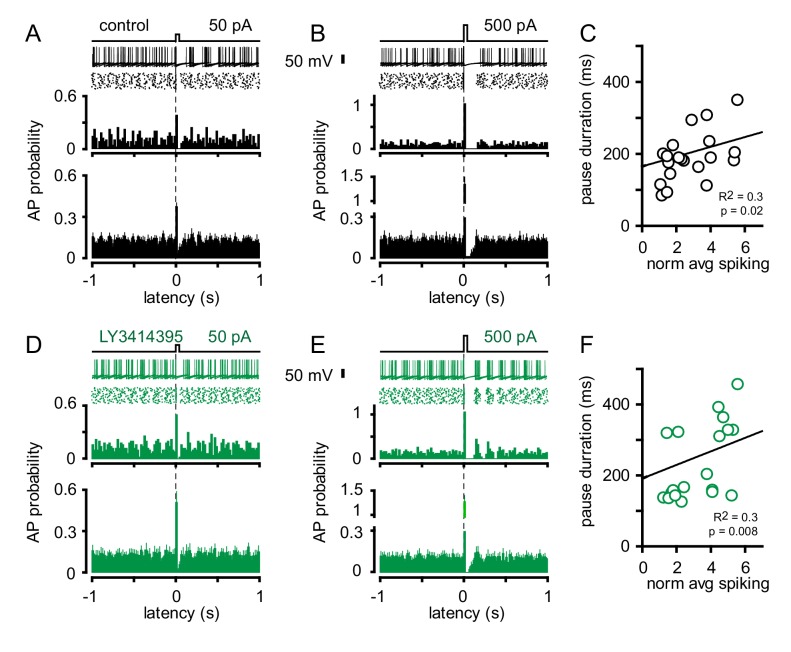
Current injections reset GoC intrinsic activity.(A) Example traces (top; 10 traces overlaid), representative raster plot and peristimulus histogram (PSH, middle) of a tonically firing GoC subjected to a 50 pA current injection (time = 0). Bottom: Average PSH of GoC spiking constructed from 20 ms bins following a 50 pA current injection (n = 5–8 cells). (B) Same paradigm as in (A) but with a 500 pA current injection. (C) Correlation of pause duration and normalized (to baseline spiking frequency) spiking (over 40 ms) following current injections (25–500 pA; n = 20) in control conditions. Slope of linear regression = 13.6 ± 6. (D, E, and F) Same experimental design as above with the addition of 0.5 µM LY3414395 (n = 5–8 cells and 20 experiments). Slope of linear regression = 19.1 ± 8 is not different than in control conditions (p=0.6, unpaired t-test).